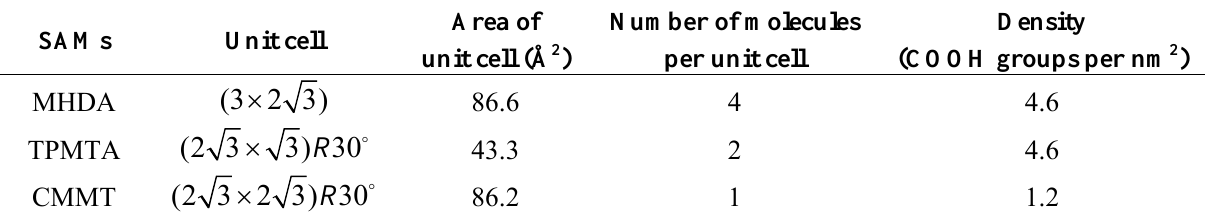
Table 1. Carboxylic acid packing density on the different types of SAMs.